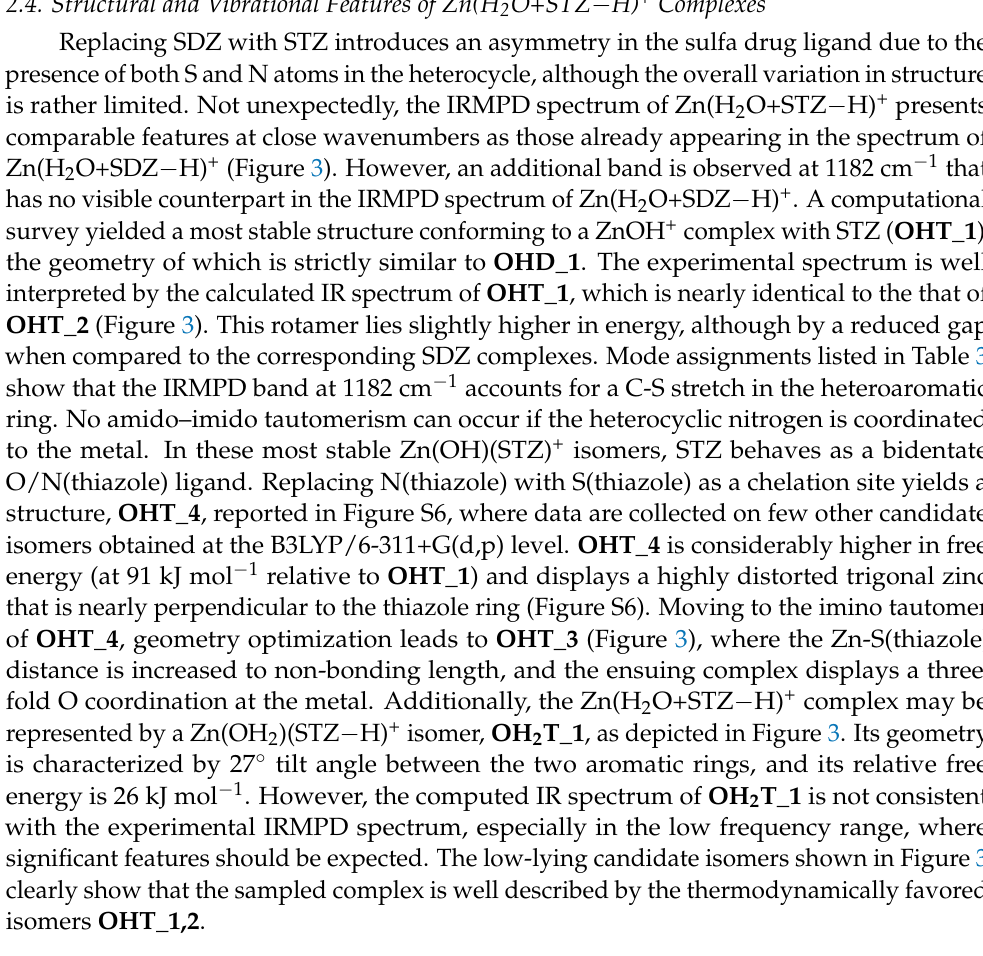
Table 3. Observed IRMPD bands of the Zn(H 2 O+STZ − H) + complex and calculated vibrational frequencies of OHT_1